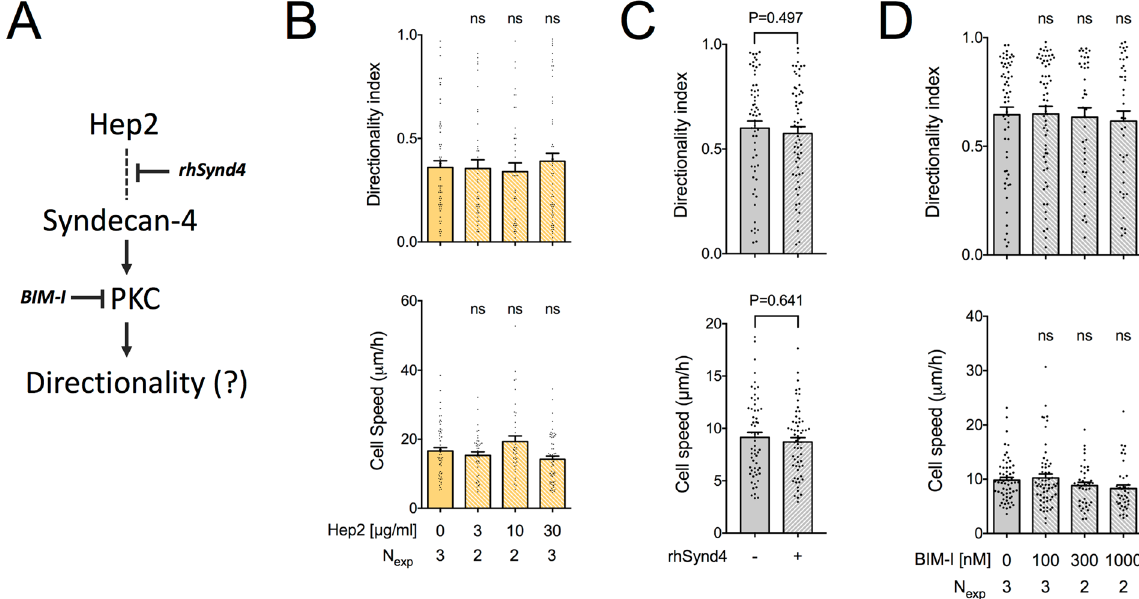
Figure 3. Syndecan-4 engagement and PKC activation are not required for high directional persistence on FN. ( A ) Model of potential syndecan-4-mediated regulation of directional persistence in migration. ( B ) REF speed and directionality index on FN120-coated substrates (10 μ g/ml) were not affected by the presence of soluble Hep2 fragments. Values in presence of Hep2 were compared to the control condition using one-way ANOVA analysis. ( C ) REF speed and directionality index on FN-coated substrates (10 μ g/ml) were not affected by the presence of a recombinant syndecan-4 ectodomain (10 μ g/ml). Values were compared using a Mann-Whitney test (N exp = 3; n = 60). ( D ) REF speed and directionality index on FN-coated substrates (10 μ g/ml) were not affected by the presence of the soluble PKC inhibitor bisindolylmaleimide I (BIM-I). Values in presence of BIM-I were compared to control conditions (same amount of DMSO as used for the highest inhibitor concentration) using one-way ANOVA analysis. N exp : number of independent experiments. Mean ± s.e.m. are presented. ns: not